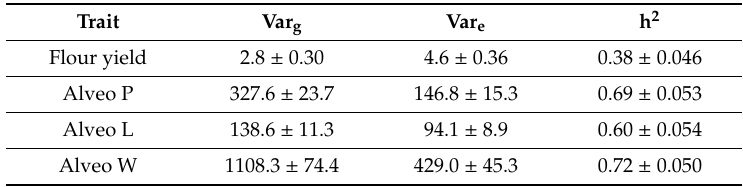
Table 2. Additive genetic variance components (Var g ), residual variance components (Var e ), and narrow-sense genomic heritabilities (h 2 ) estimated from genomic best linear unbiased prediction (GBLUP) models.